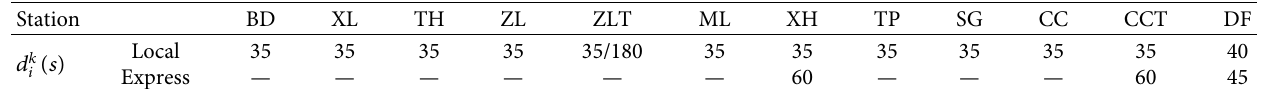
Table 7: Optimized train dwelling time at different stations.